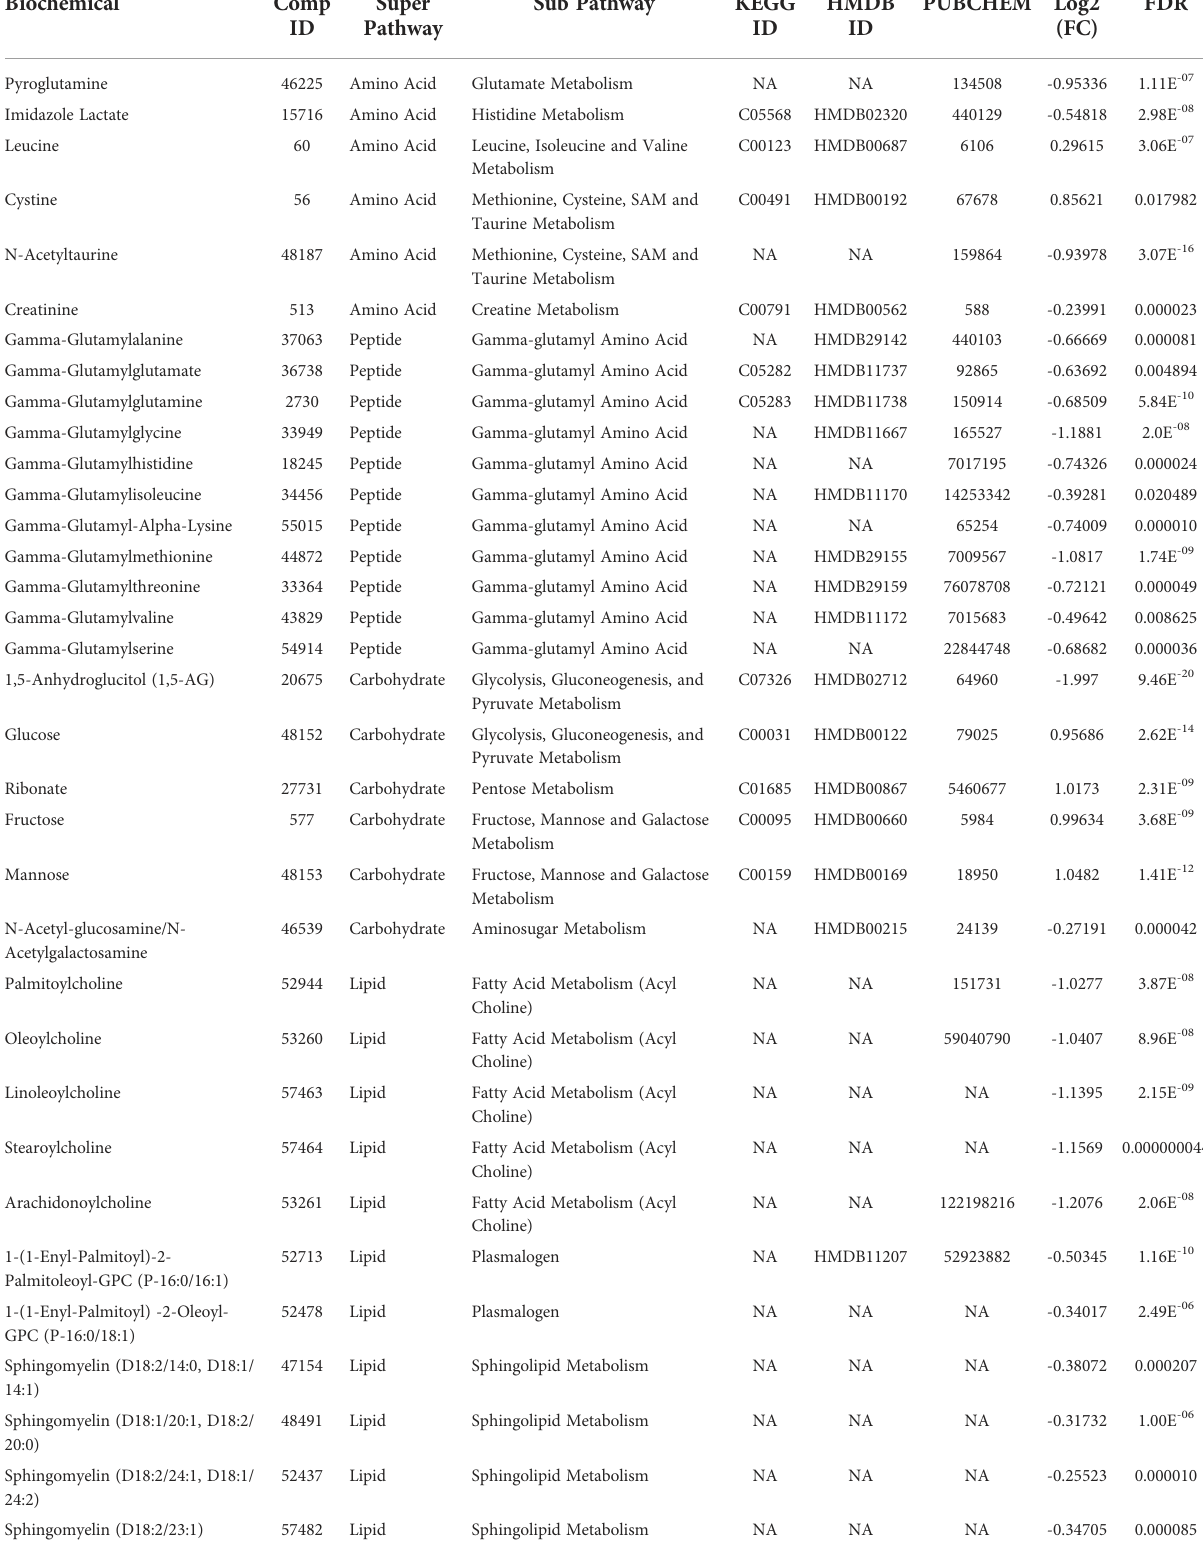
TABLE 2 Signi fi cant Serum Metabolites in Youth with T2D.